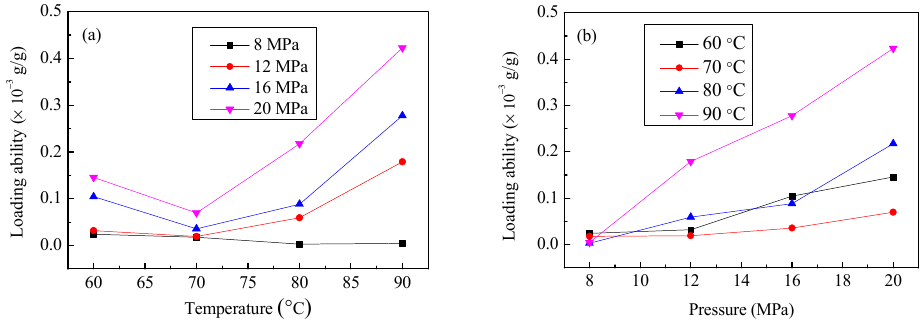
Figure 5. Effect of SCF-CO 2 treatment conditions on the LA of resveratrol onto diacetate fiber: ( a ) SCF-CO 2 treatment temperature; ( b ) SCF-CO 2 treatment pressure.